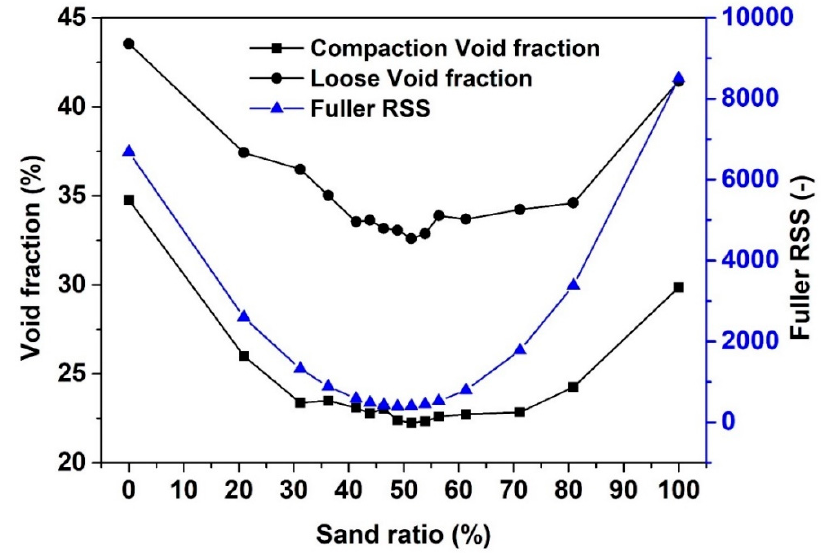
Figure 5. Void fraction and Fuller RSS (Cf. Equation (3)) as a function of sand volume fraction in sand-gravel mixtures.